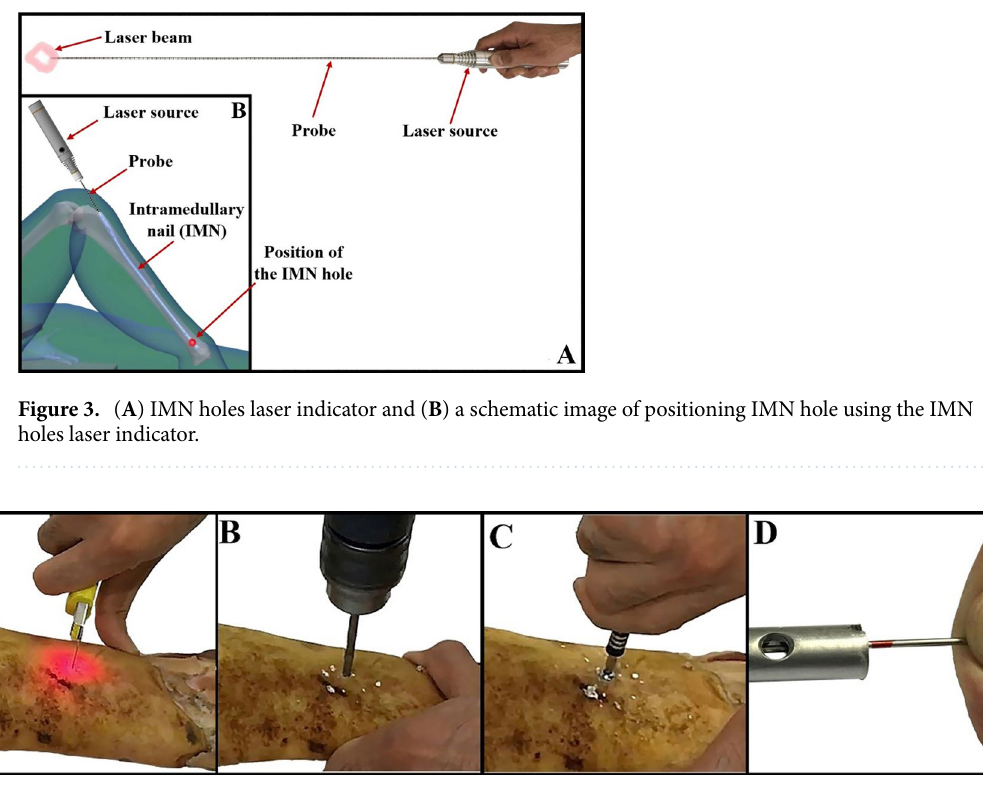
Figure 4 . Intramedullary nailing for one of the samples, ( A ) determining the position of the IMN hole and skin incision, ( B ) bone drilling, ( C ) fastening the interlocking screw, ( D ) checking the screw insertion inside the IMN